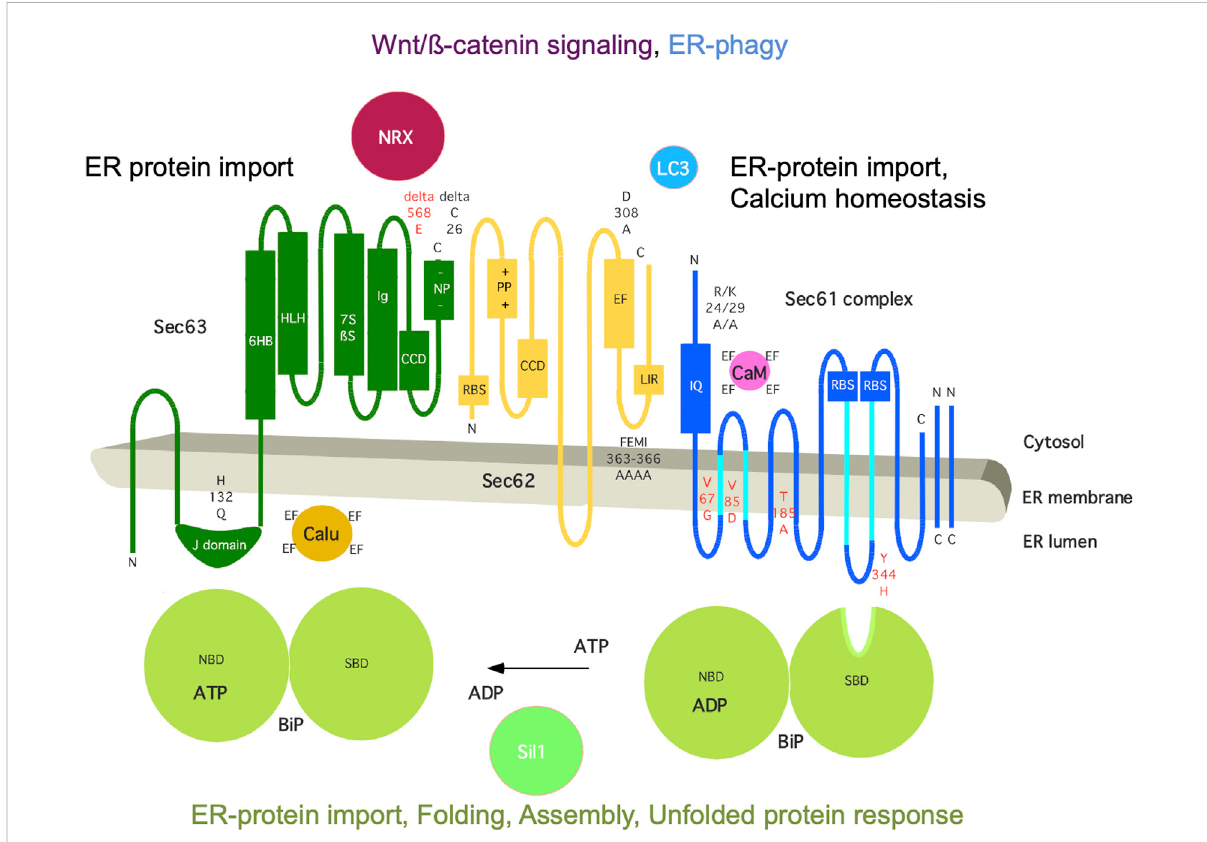
FIGURE 5 ThehumanERmembraneproteinSec62ispartofadynamicproteinnetwork.Topologyandfunctionallyrelevantdomainsoftheheterotrimeric Sec61 complex and its allosteric effectors BiP, Sec62 and Sec63 are shown (Mayer et al., 2000; Tyedmers et al., 2000). The cytosolic loops six and eight of the α -subunit of the Sec61 complex comprise a binding site for ribosomes (termed RBS) and ER-lumenal loop 7 a binding site for BiP (Schäuble et al., 2012; Cheng et al., 2015); the N-terminus of the same subunit contains an IQ-motif for binding of Ca 2+ -calmodulin (CaM) (Erdmann et al., 2011). The cofactors of BiP, Sec63 and Sil1, are also shown, as are additional interaction partners of Sec62 (LC3) and Sec63 (nucleoredoxin/NRX,calumenin/Calu)(Tyedmers etal.,2005;Mülleretal.,2011;Fumagallietal.,2016).Disease-associated mutationsofSec61 α and Sec63areindicatedinred(aminoacidresiduesaregiveninsinglelettercode)(reviewedbySickingetal.,2021),asarerationallydesignedmutationsin black, such as Sec61 α R24A/K29A (Erdmann etal., 2011), Sec62 D308A (Linxweiler et al., 2013), Sec62 FEMI363-366AAAA (Fumagalli et al., 2016), and Sec63 H132Q as well as Sec63 deltaC26 (Müller at al., 2010; Haßdenteufel et al., 2018; Schorr et al., 2020). C, C-terminus; CCD, coiled-coil domain for protein interaction; EF, EF hand; IQ, IQ-motif for CaM binding; LIR, LIR-motif for LC3 binding; N, N-terminus; NBD, nucleotide binding domain; -NP-, patch with negatively charged amino acid residues; +PP+, patch with positively charged amino acid residues; RBS, ribosome binding site; SBD, substrate binding site. The Figure and Figure legend were adapted from Sicking et al.